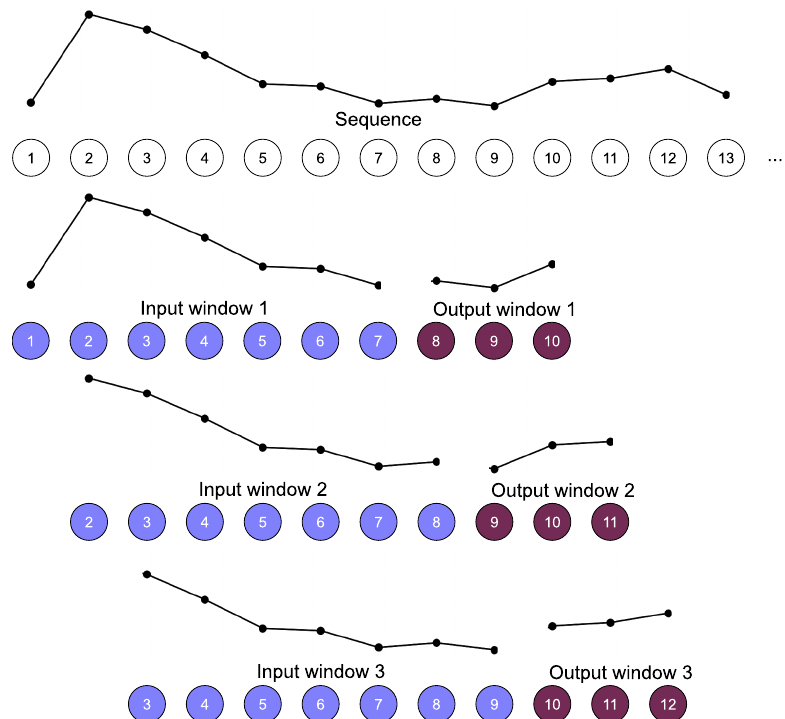
Figure 3. Moving window procedure that obtains the input–output instances. In this example, the input and output windows have lengths of 7 and 3,